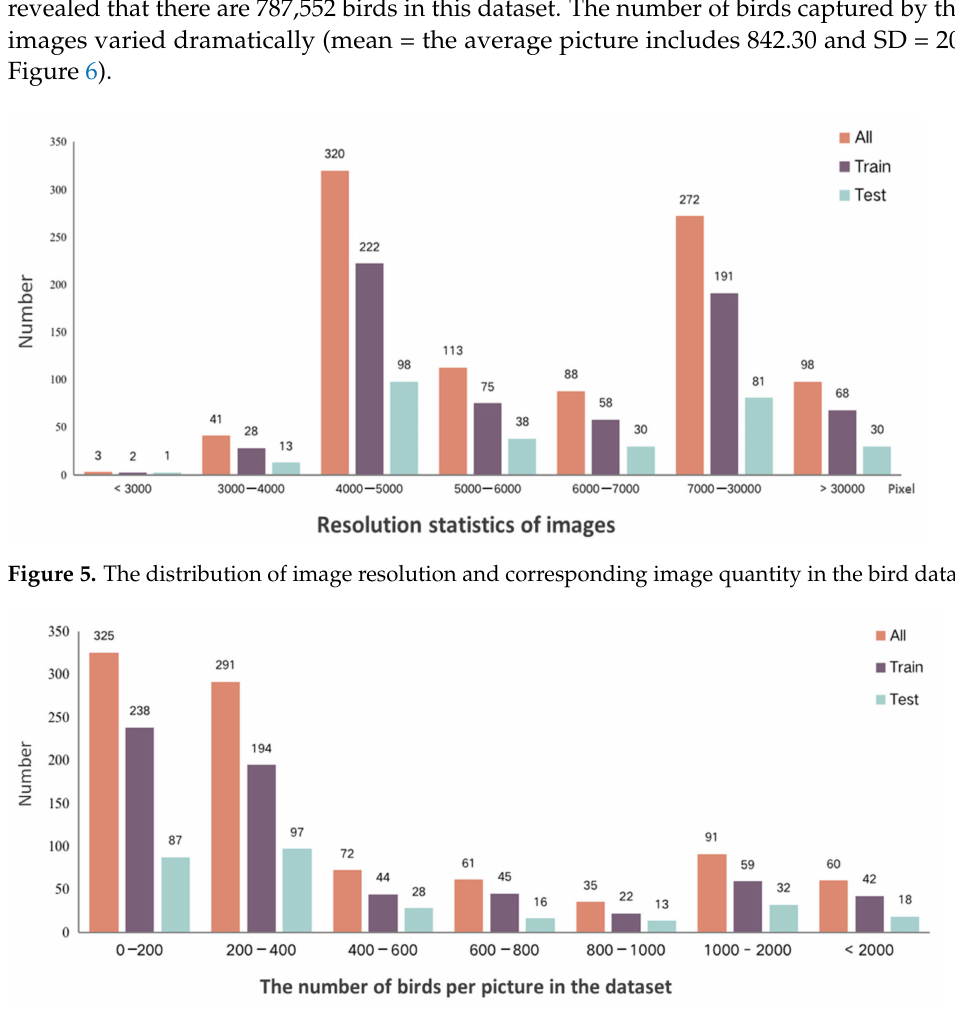
Figure 6. The distribution of the number of birds and the corresponding number of training and testing